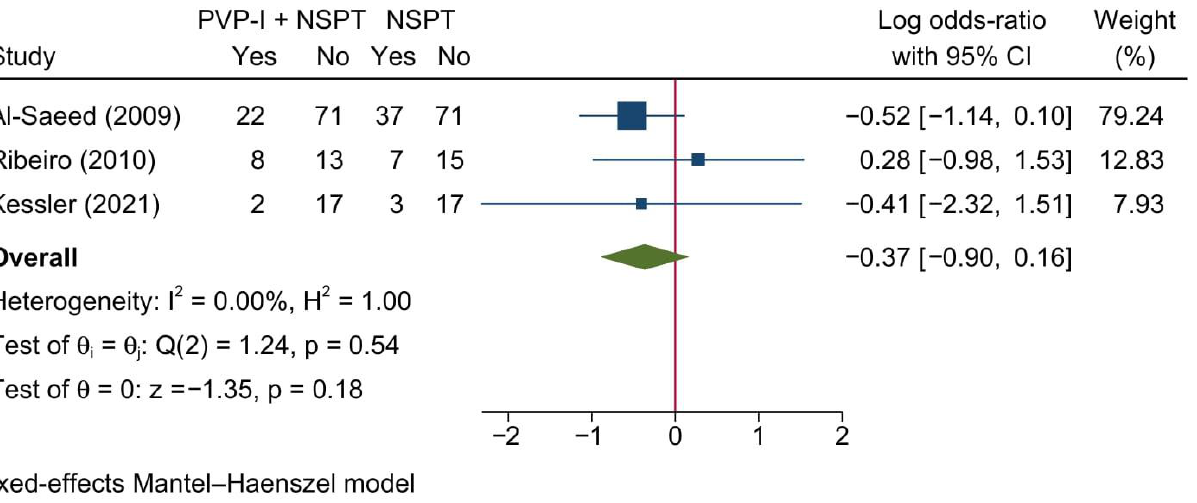
Figure 6. Forest plot showing the comparison between PVP-I + NSPT and NSPT alone regarding bleeding on probing (dichotomous variable) [38,42,46].